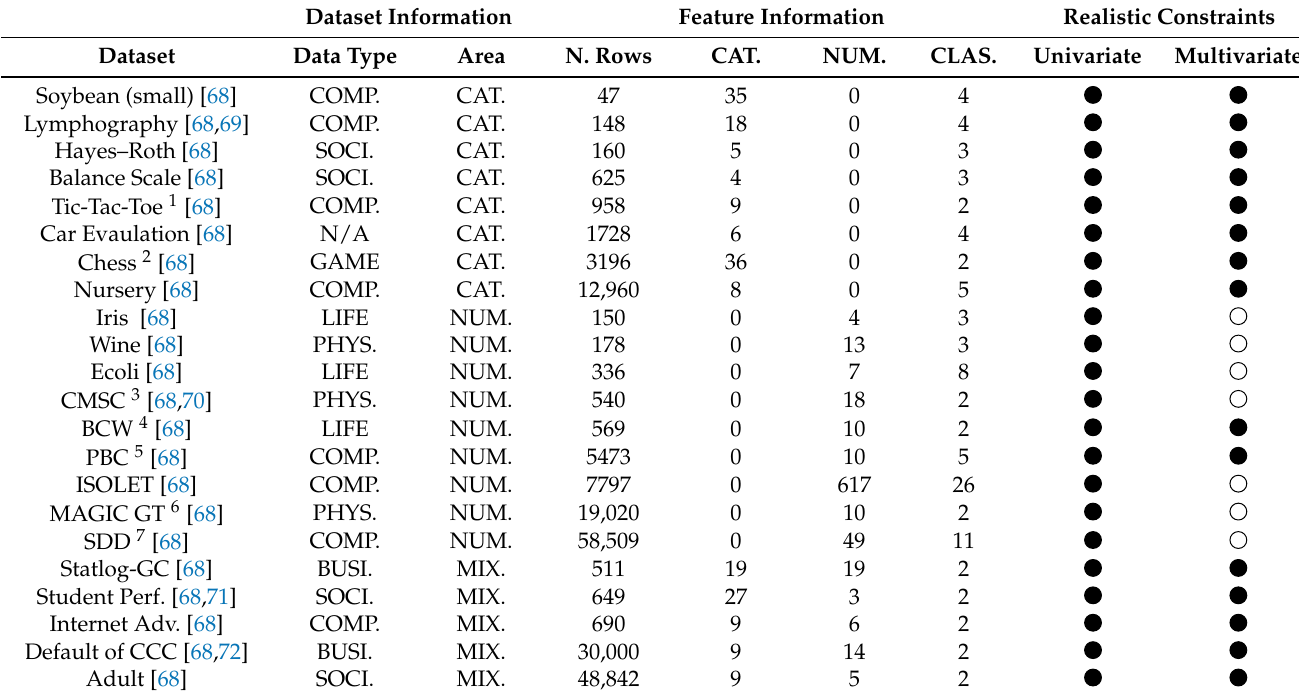
Classification. 6 MAGIC Gamma Telescope. 7 Sensorless Drive